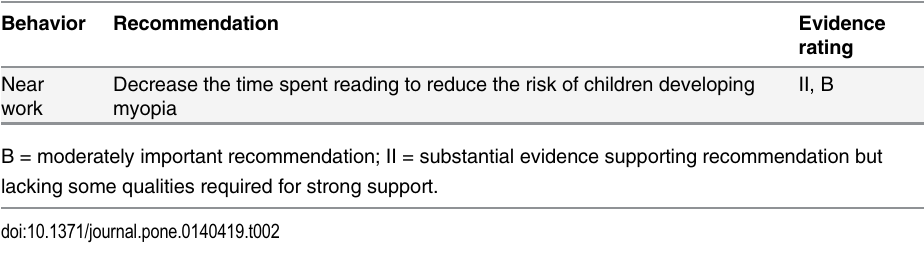
Table 2. Clinical recommendations for the different